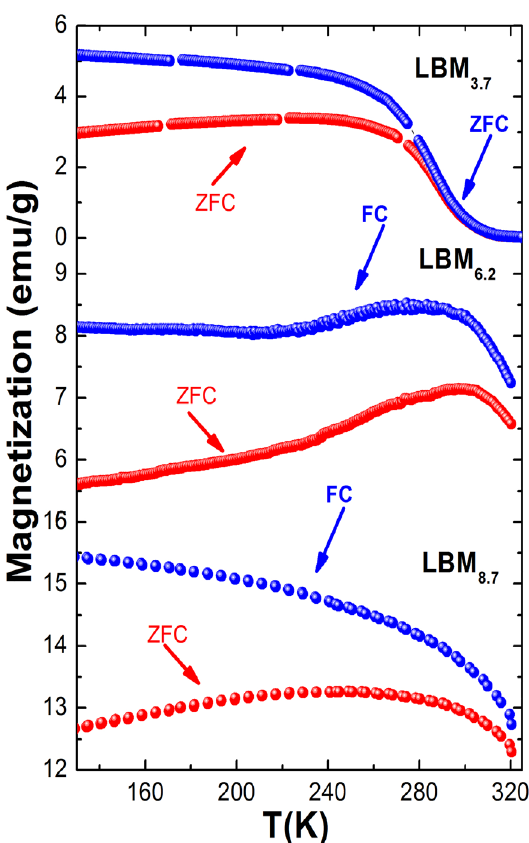
Figure 4. Field Cooled and Zero Field Cooled Magnetizations for Samples LBM3.7, LBM6.2 and LBM8.7. Figures 2 (d)-(f) show SEM images with magnification of 30 kx for all the samples analyzed. We observe that sample LBM consists of crystallites with sizes ranging from 0.50 - 3.7 1.82 µm with a mean crystallite size of 1.11µm. For samples LBM and LBM , the average diameters obtained 6.2 8.7